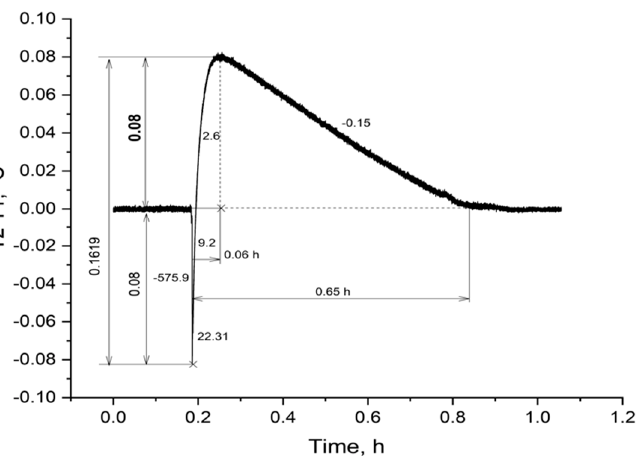
Figure 2. Change in temperature in a thornback ray erythrocyte suspension upon addition of ATP. Note: the figures along the curve are the rate of the process, expressed in °C/h.